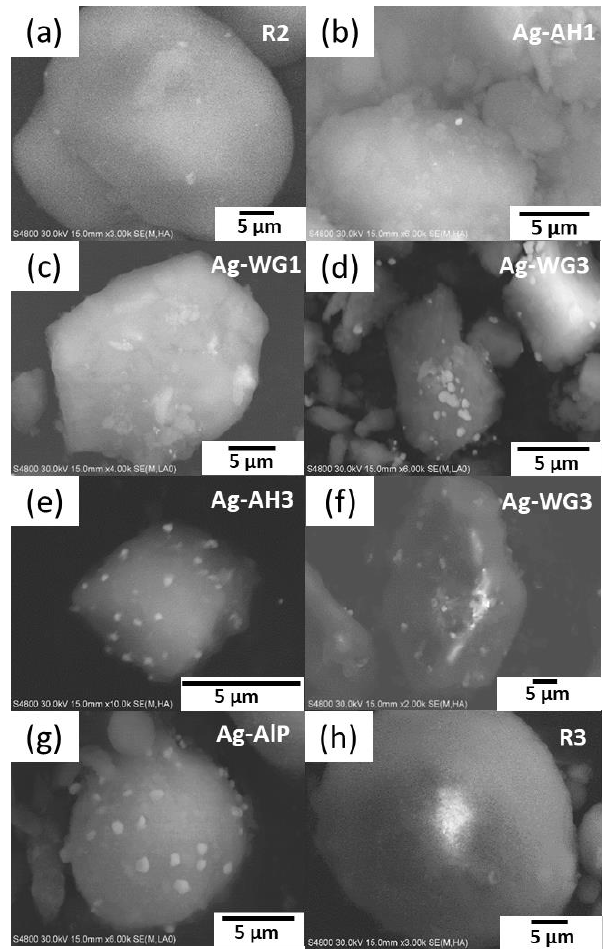
Figure 2. SEM images of catalysts prepared in this study: ( a ) R2, ( b ) Ag-AH1, ( c ) Ag-WG1, ( d ) Ag-WG3, ( e ) Ag-AH3, ( f ) Ag-WG2, ( g ) Ag-AlP and ( h ) R3. Scale bars: 5 µm. For more details about the